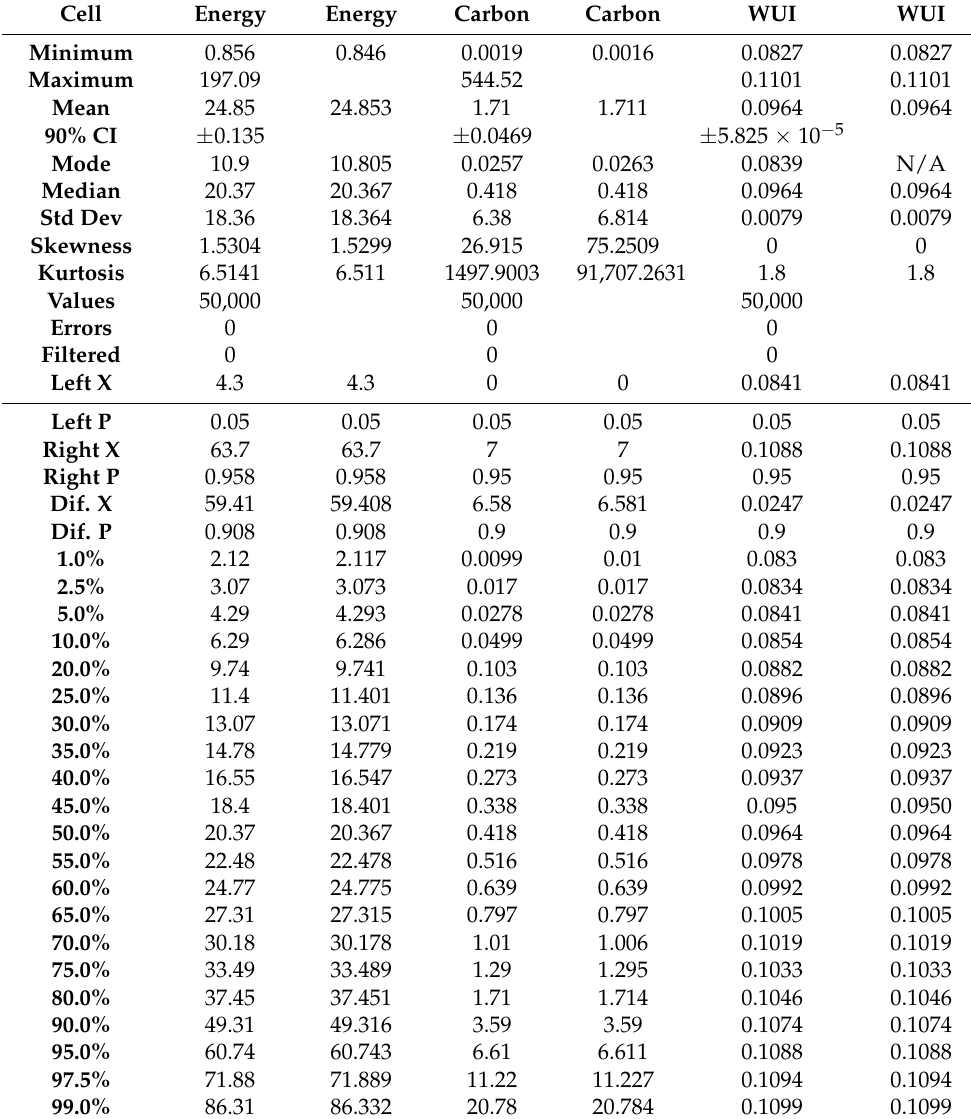
Table A7. Probabilistic results and their statistical